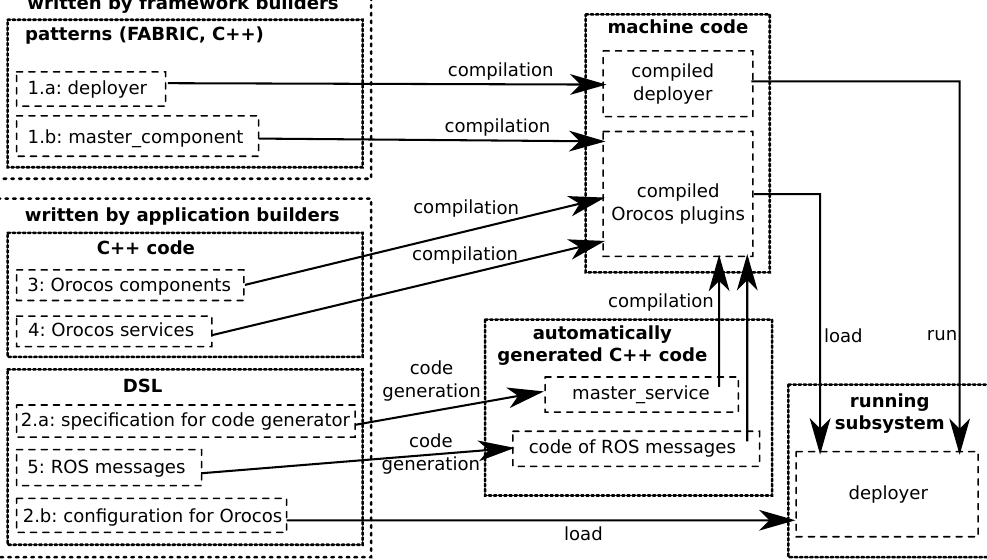
Figure 17. Creation of Subsystem executable code basing on its library source code and specification as well as subsystem deployment in run-time